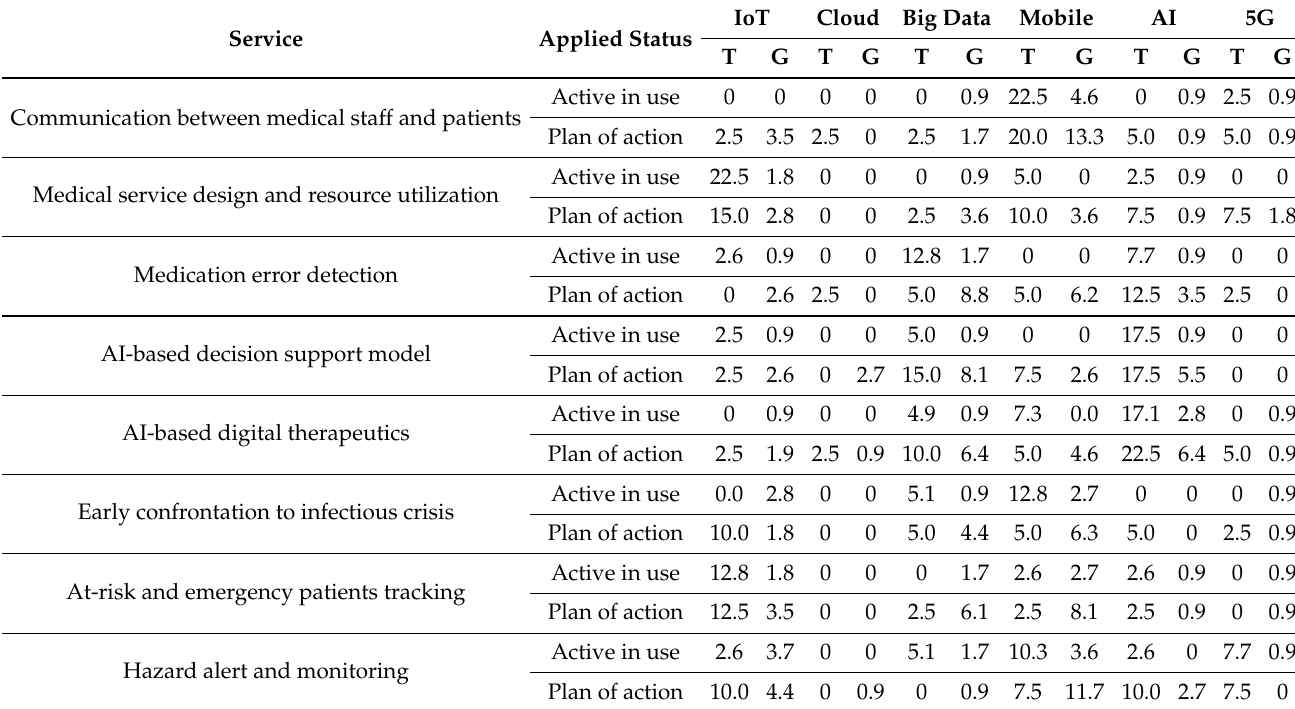
Table 4. Smart hospital core technology and significant service use.